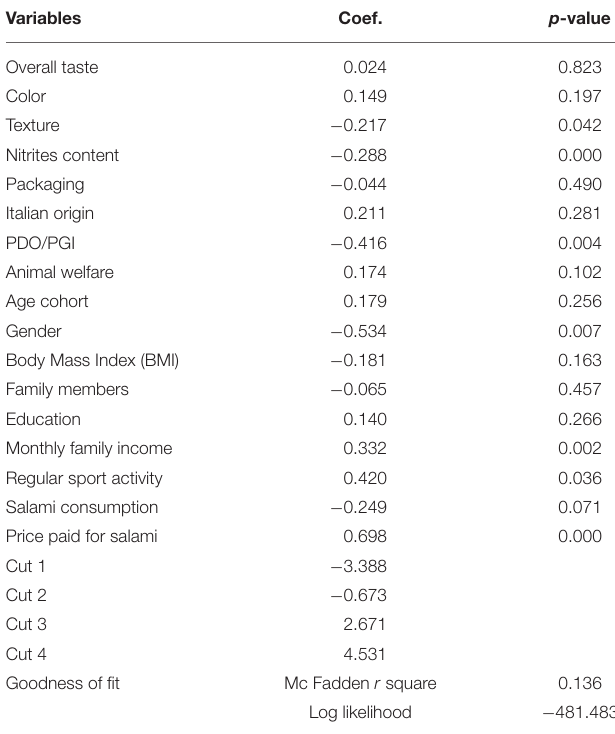
TABLE 2 | Descriptive statistics of the variables used in the Ordered Logit model. TABLE 3 | Ordered logit model results on WTP for reduced fat salami ( n = 484). Variables